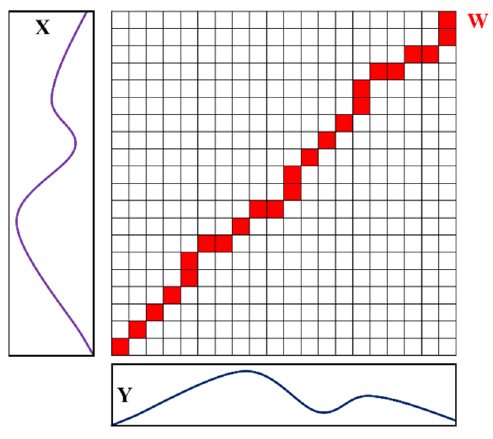
Figure 6. The optimal warping path between time series X and Y (red squares).